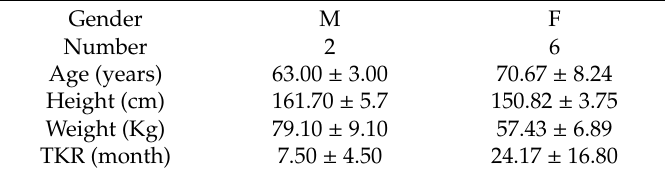
Table 4. Total knee replacement (TKR) subjects’